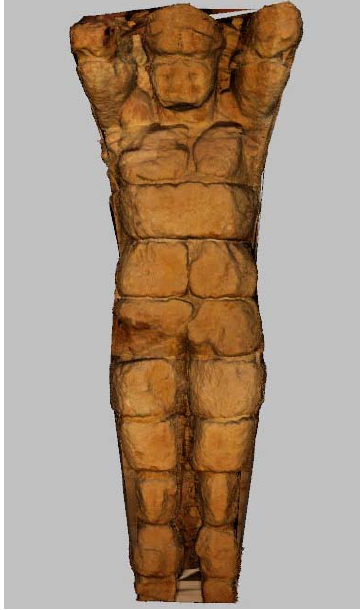
Figure 13. Image Master 3D